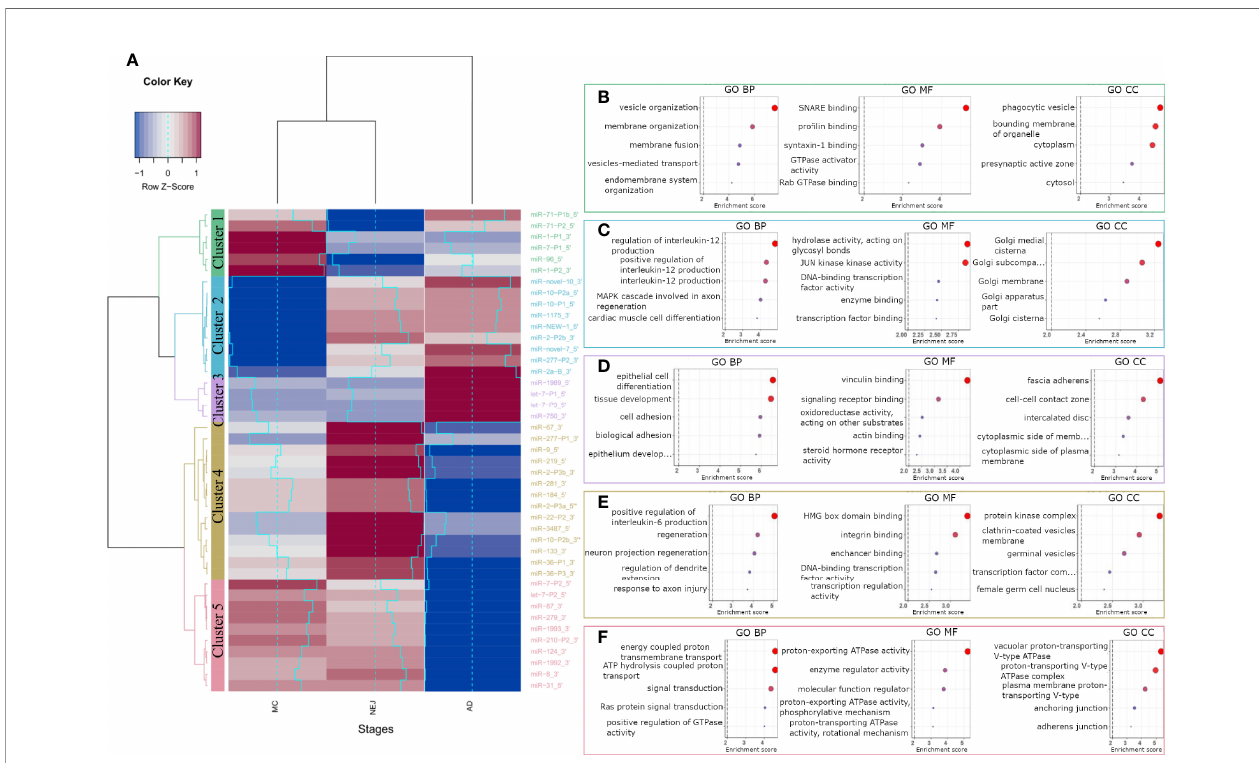
FIGURE 3 | GO terms enrichment of differentially expressed miRNAs between metacercariae, NEJ and adult stages. (A) Heatmap of the differences in the expression between stages. MiRNAs were grouped into 5 clusters based on their expression pro fi les: cluster 1 (green), cluster 2 (blue), cluster 3 (purple), cluster 4 (yellow) and cluster 5 (pink). A gradual change in color ranging from blue to red indicates the low-to-high expression, additionally light-blue line re fl ects the variation in the Log2FC. (B – F) Top 5 biological process (BP), molecular function (MF) and cellular component (CC) terms ordered by p-value, enriched in the predicted targeted genes of clusters 1-5, respectively (a color code like in A was applied). Enrichment score was calculated as -Log of p-value, terms with a score ≥ 2 (p-value = 0.01, dashed line) were considered signi fi